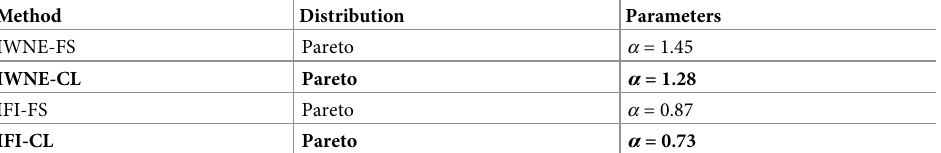
Table 2. Distribution fitting for the eigenvalues of the activations of the first layer. For all the four models, the eigenvalues are best parametrized by a Pareto distribution. We also find that the self-supervised models show smaller value for the shape parameter of the Pareto distribution.